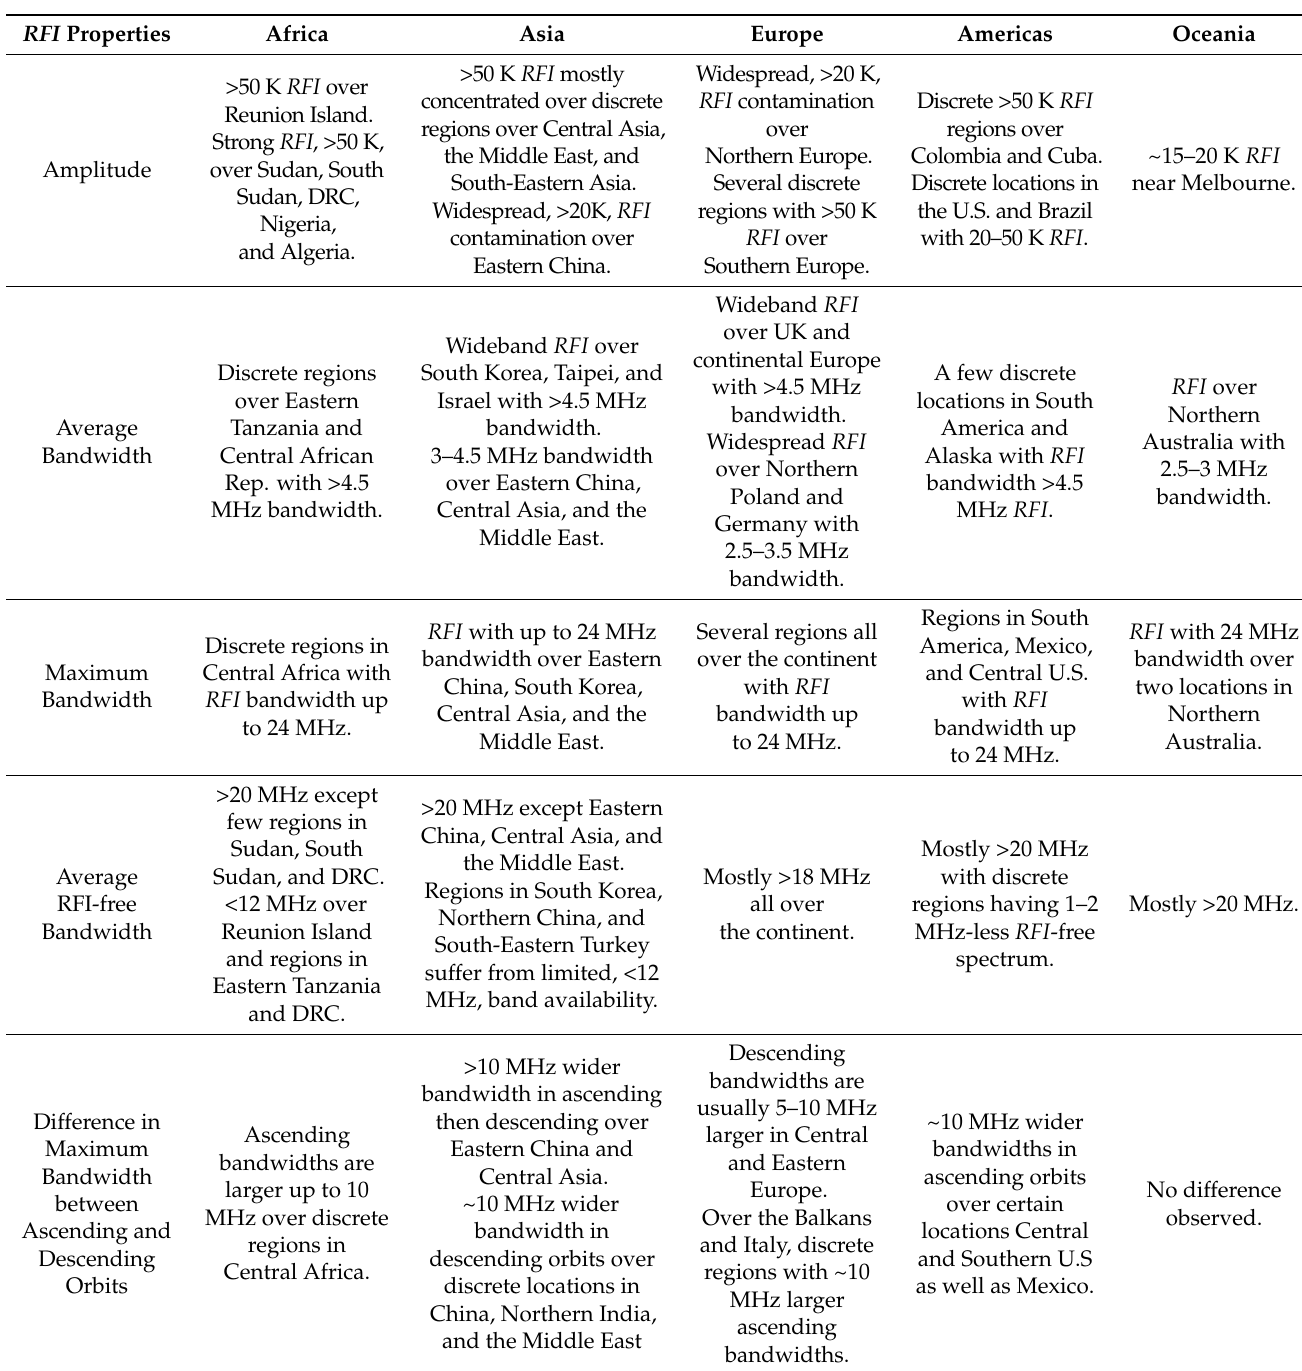
Table 1. L-band RFI properties over different